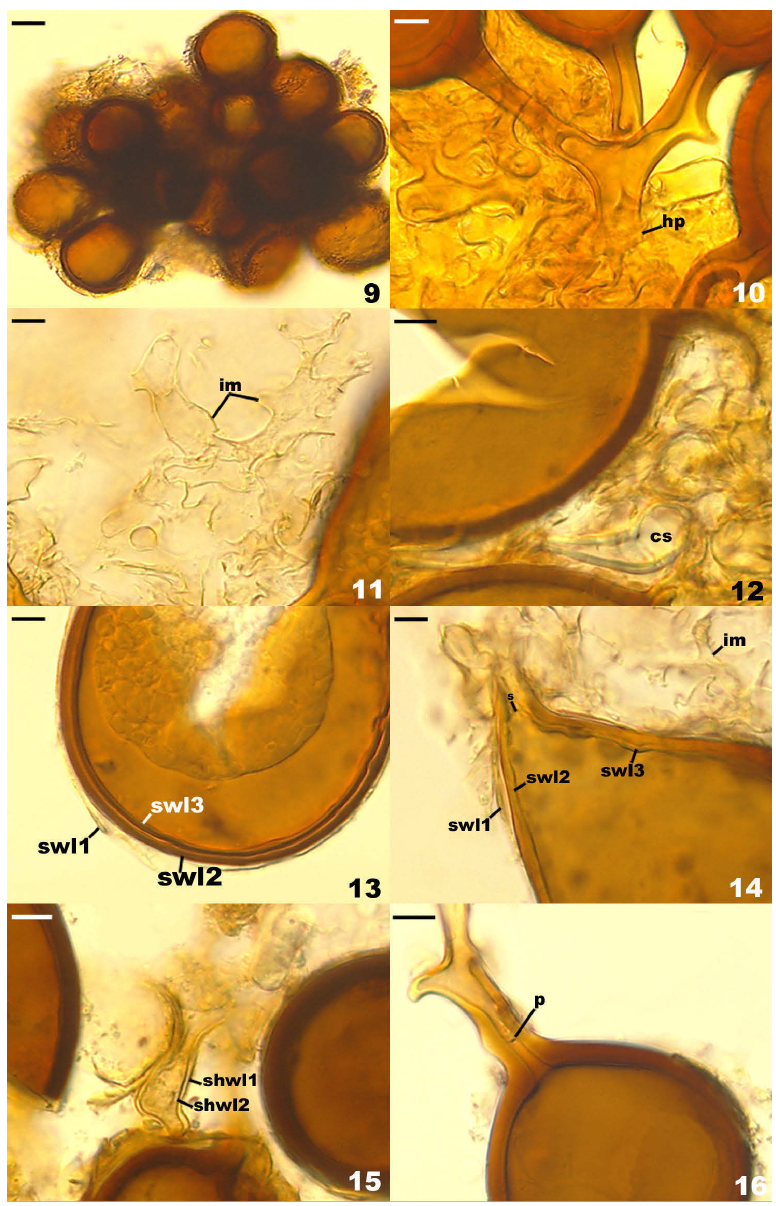
Figs 9-16. Glomus badium . 9. Sporocarp. 10. Hyphal plexus (hp). 11. Interspore mycelium (im). 12. Cystidium-like structure (cs). 13. Spore wall layers 1-3 (swl1-3). 14. Spore wall lay- ers 1-3 and interspore mycelium (im); septum (s) of the subtending hypha formed by spore wall layer 3 is indicated. 15. Subtending hyphal wall layers 1 and 2 (shwl-2). 16. Plug (p) in the lumen of subtending hypha. Figs 9 and 11-16, spores crushed in PVLG. Fig. 10, spore crushed in PVLG+Melzer’s reagent. Figs 9-16, differential interference contrast. Scale bars for Fig. 9=20 μm, for Figs 10-16=10